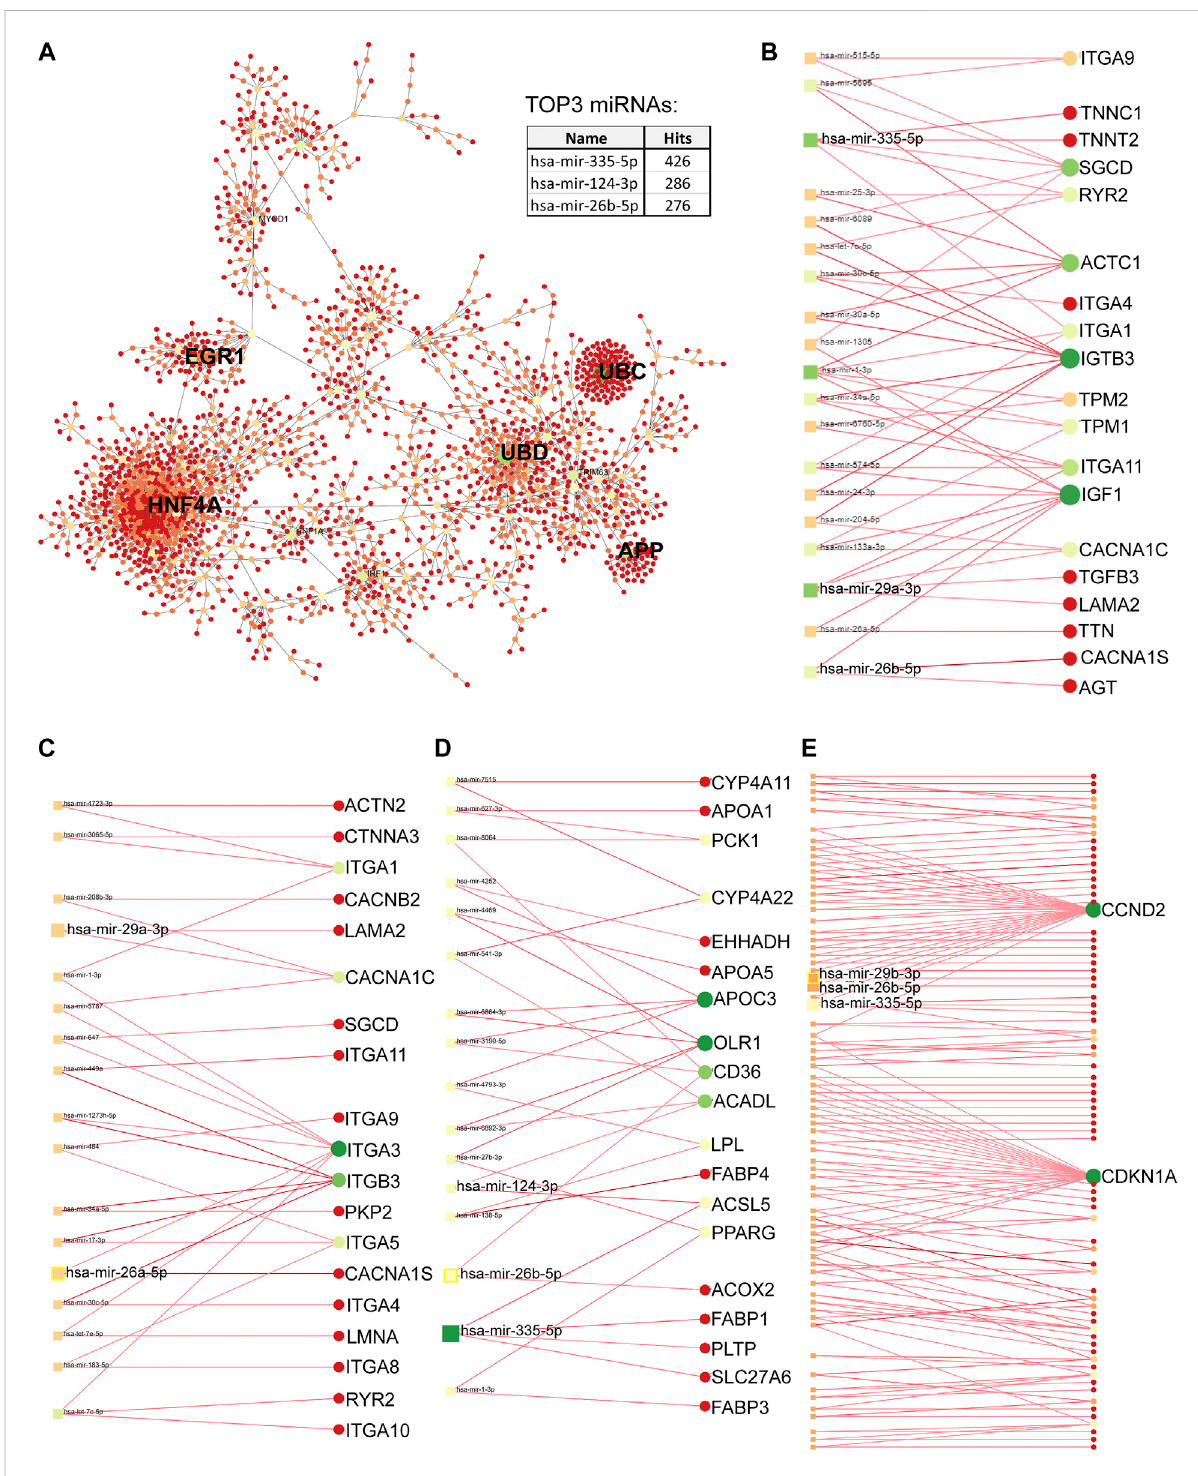
FIGURE 7 Protein-protein interaction network analysis based on differentially upregulated genes in DMD-COs using Network Analyst platform. (A) Top fi ve main hub genes (HNF4A, UBC, UBD, APP and EGR1) were identi fi ed based on the degree levels. The gene-miRNA networks for hypertrophy/ dilated cardiomyopathy (B) , arrhythmogenic right ventricular cardiomyopathy (C) , PPARgamma (D) and PI3K-Akt (E) signalling pathways, respectively. The colours indicate the degree of interaction (with lowest to highest degree from red to yellow to green), whereas the sizes of circles indicate the degree of betweenness of a node (larger size means higher degree of betweenness). The identi fi ed top three miRNAs by PPI and top two miRNAs by gPro fi ler2 analysis were mapped in each gene-miRNA network to indicate the genes they interact